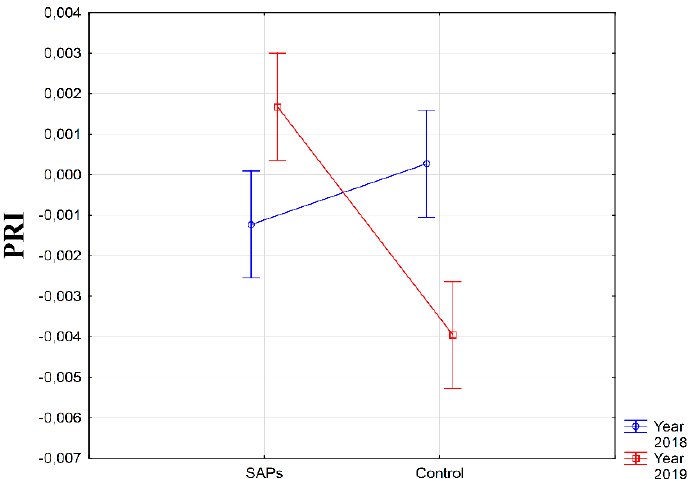
Figure 6. Interaction between experimental treatments and years for photochemical reflectance (PRI). Figure was obtained at level of significance α = 0.01. index (PRI). Figure was obtained at level of significance α = 0.01.